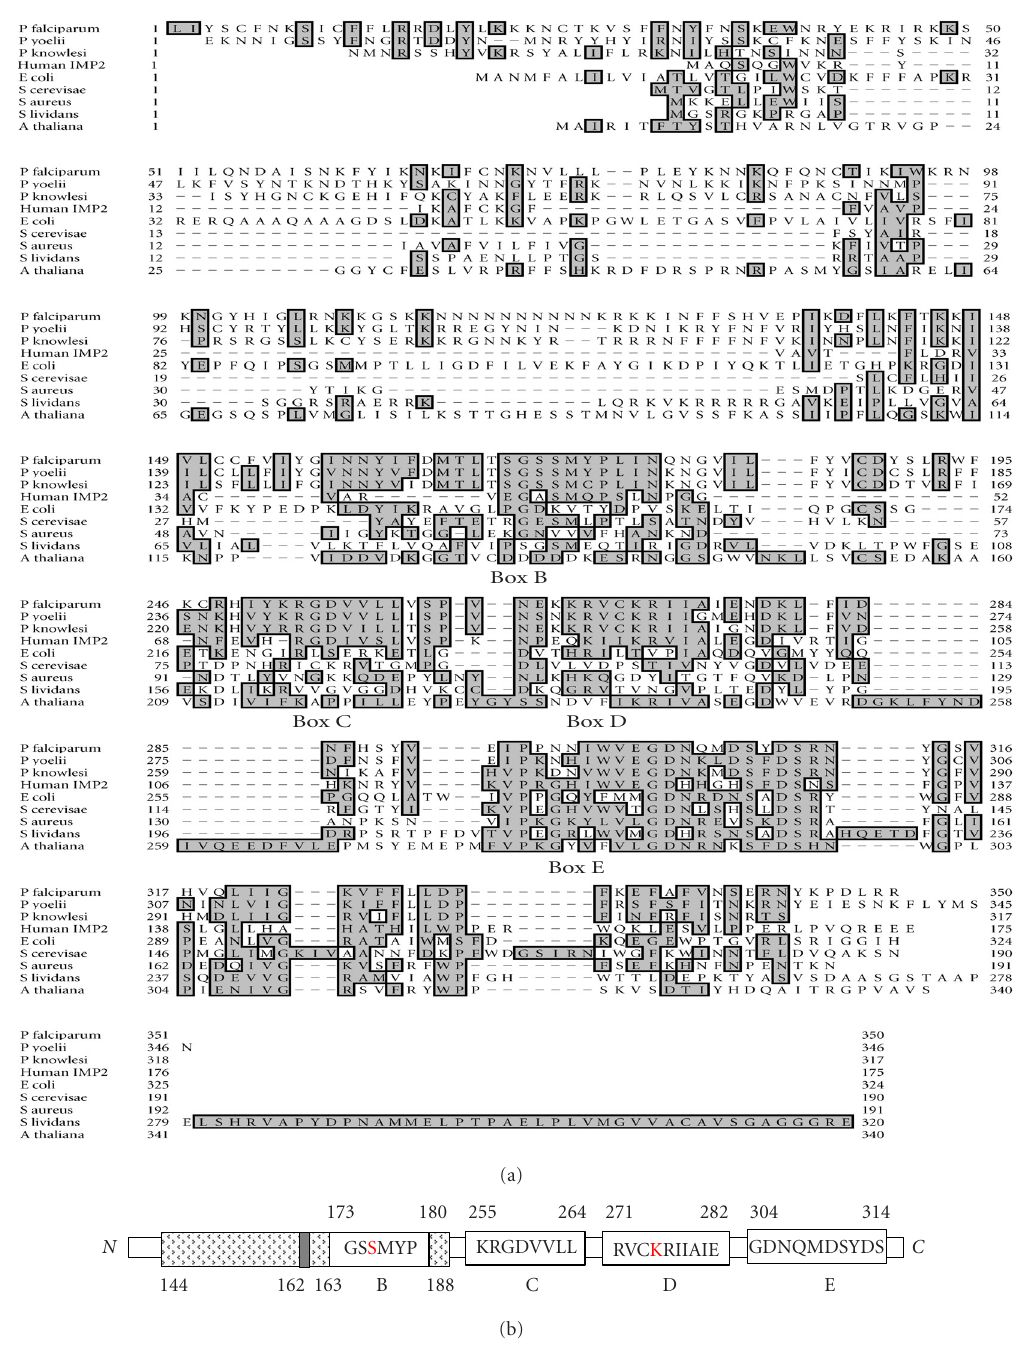
Figure 2. (a) Multiple alignment of type I signal peptidases from P falciparum (DDBJ/EMBL/GenBank accession number AY582351; protein id AAS91735), P yoelii (DDBJ/EMBL/GenBank accession number AY787663; protein id AAV71057), P knowlesi (DDBJ/EMBL/GenBank accession number AY787662; protein id AAV71056), human IMP2 (mitochondrial inner membrane pepti- dase NP 115938), E coli (BAA10915), Saccharomyces cerevisae (NP 013870), Staphylococcus aureus (NP 371489), Streptomyces lividans (CAB06808), and Arabidopsis thaliana (CAA71502). The conserved boxes are also labeled. (b) Schematic diagram showing the various conserved boxes B–E and the probable transmembrane regions of type I signal peptidase from P falciparum . Open boxes represent the conserved type I signal peptidase motifs and the amino acid sequence of each motif is written by the single letter code inside the box. Labels below the open boxes (B–E) are the names assigned to the motifs. The amino acids of the catalytic dyad are shown in red. The numbers above the boxes represent the boundaries for each box in P falciparum . Shaded boxes represent the two transmembrane regions and the numbers below the boxes represent the boundaries for these regions. The gray shaded area is the overlapping region in the two transmembrane regions. N and C denote the N and C -terminal ends of the